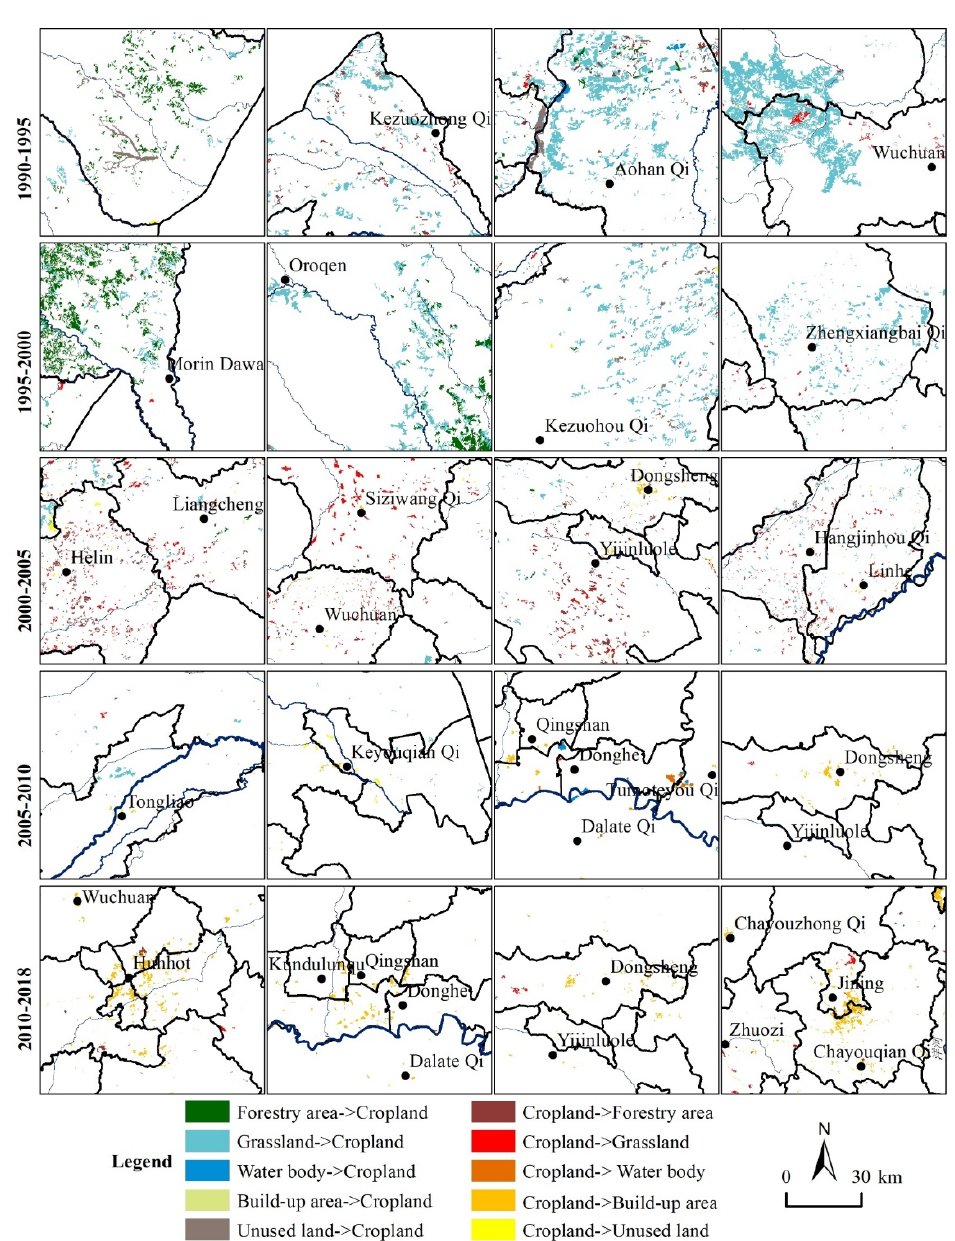
Figure 5. Spatial change patterns of the converted cropland types in typical areas of Inner Mongolia from 1990–2018. Please note: the symbol ”->” represents the conversion direction between the two land types.